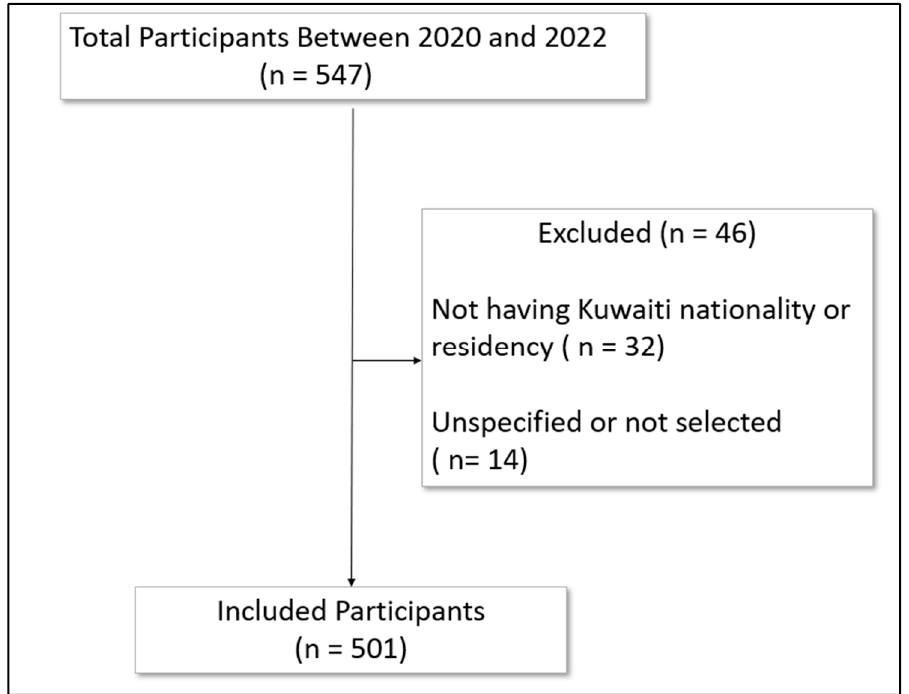
Figure 1. Flow diagram of the included